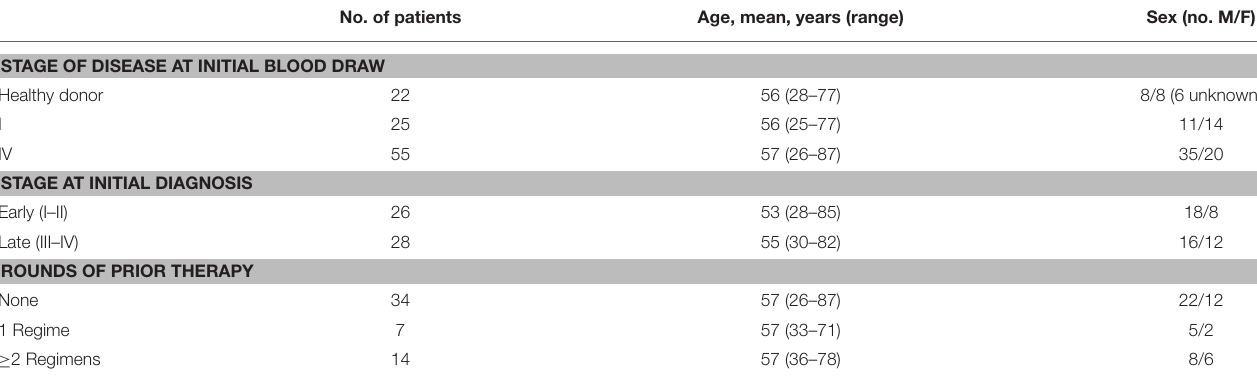
TABLE 1 | Clinical characteristics of enrolled patients.